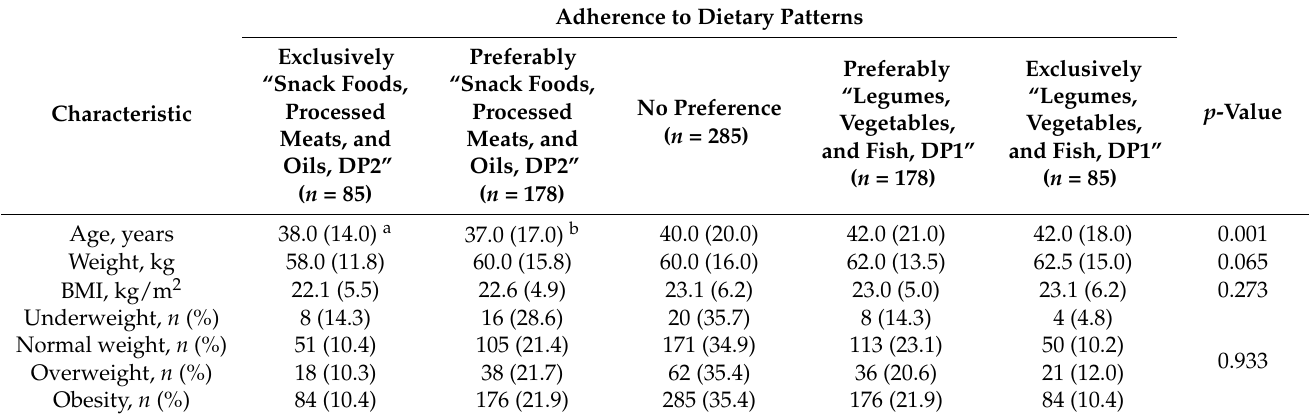
Table 3. Characteristics of 811 Italian women by adherence to dietary patterns.